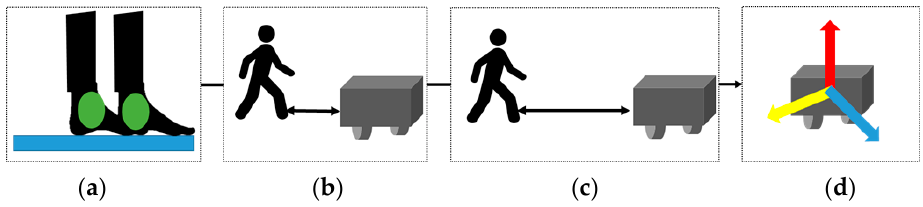
Figure 4. A procedure for driving of the moving part: ( a ) foot coordinates reception; ( b ) calculation of distance between trainee; ( c ) maintenance distance based on calculated distance; ( d ) calculation of training distance based on robot‘s travel distance.